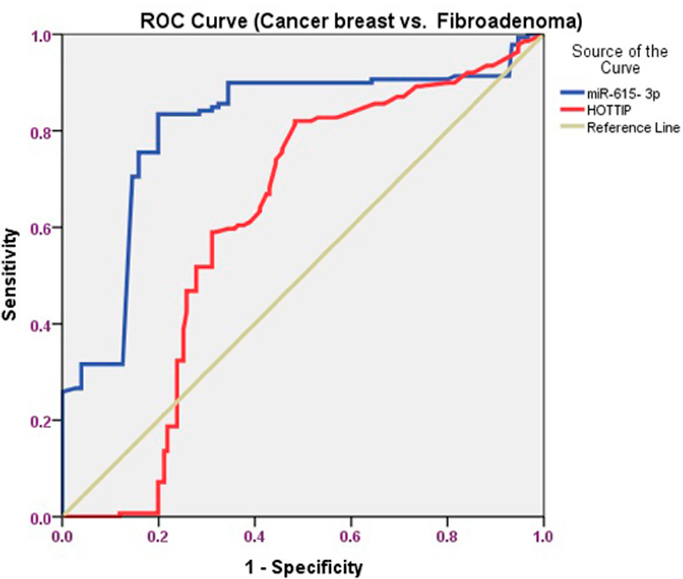
Figure 4. ROC curve analysis of the serum HOTTIP and miR-615-3p for differentiating BC patients from patients with FA.